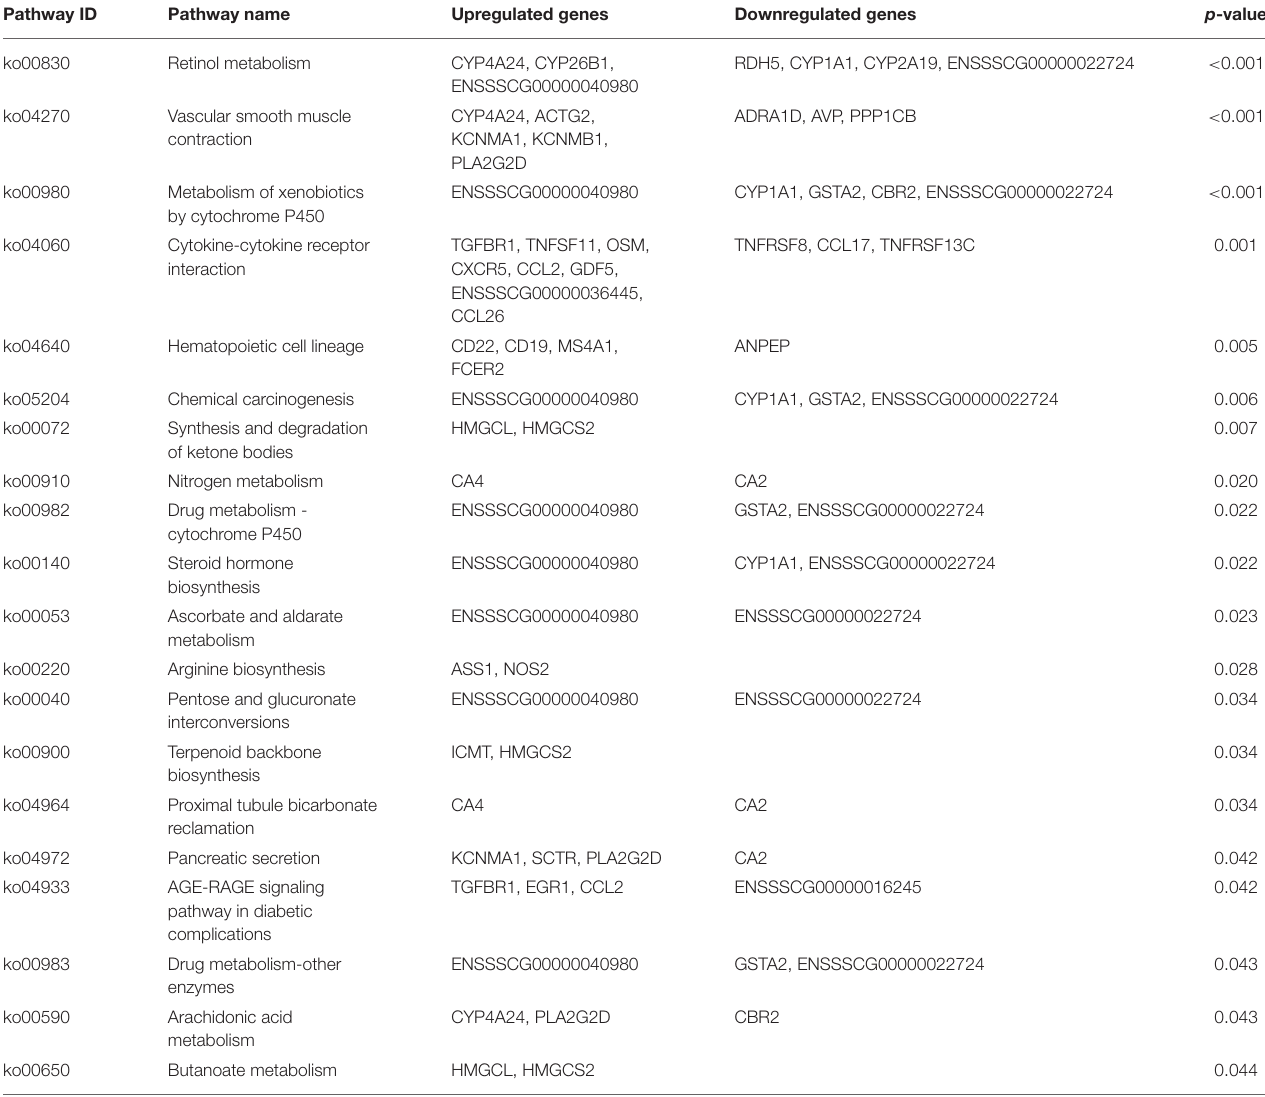
TABLE 4 | KEGG pathway enrichment of DEGs (CSC vs. CON). Pathway